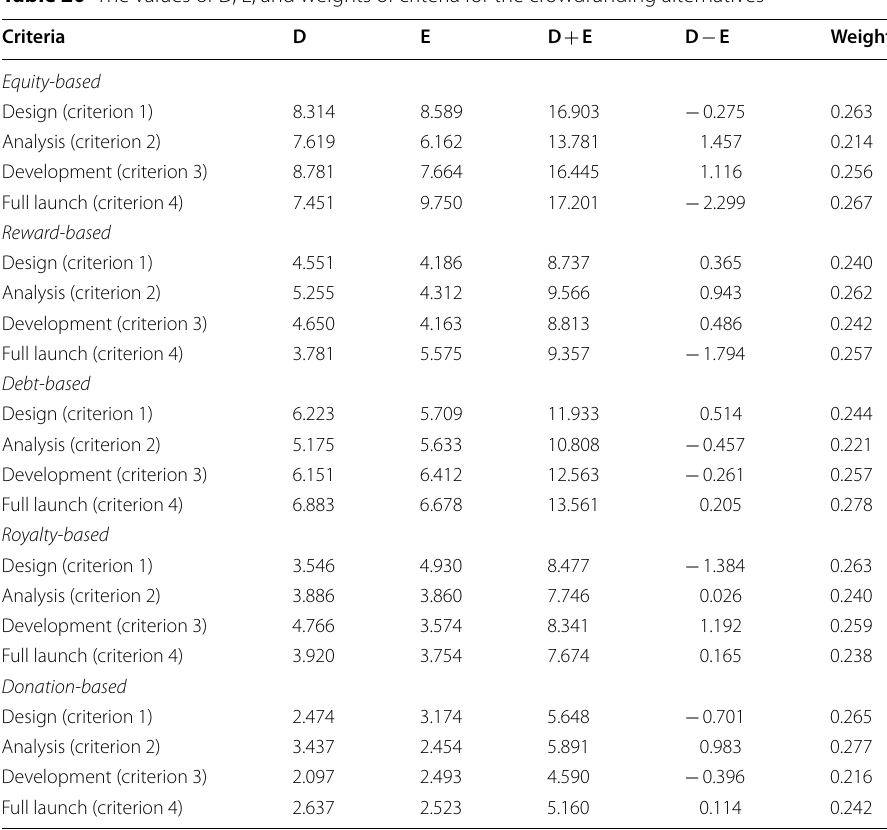
Table 20 The values of D, E, and weights of criteria for the crowdfunding alternatives Criteria D